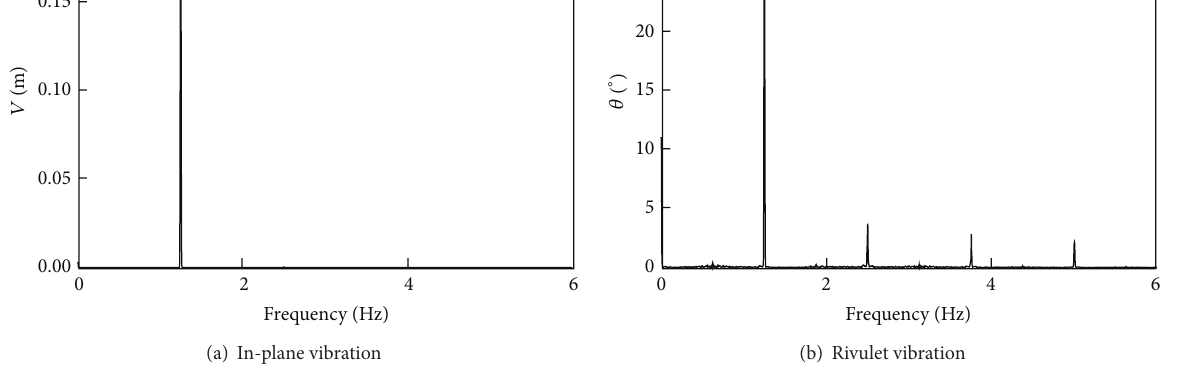
Figure 3: Vibration frequencies.